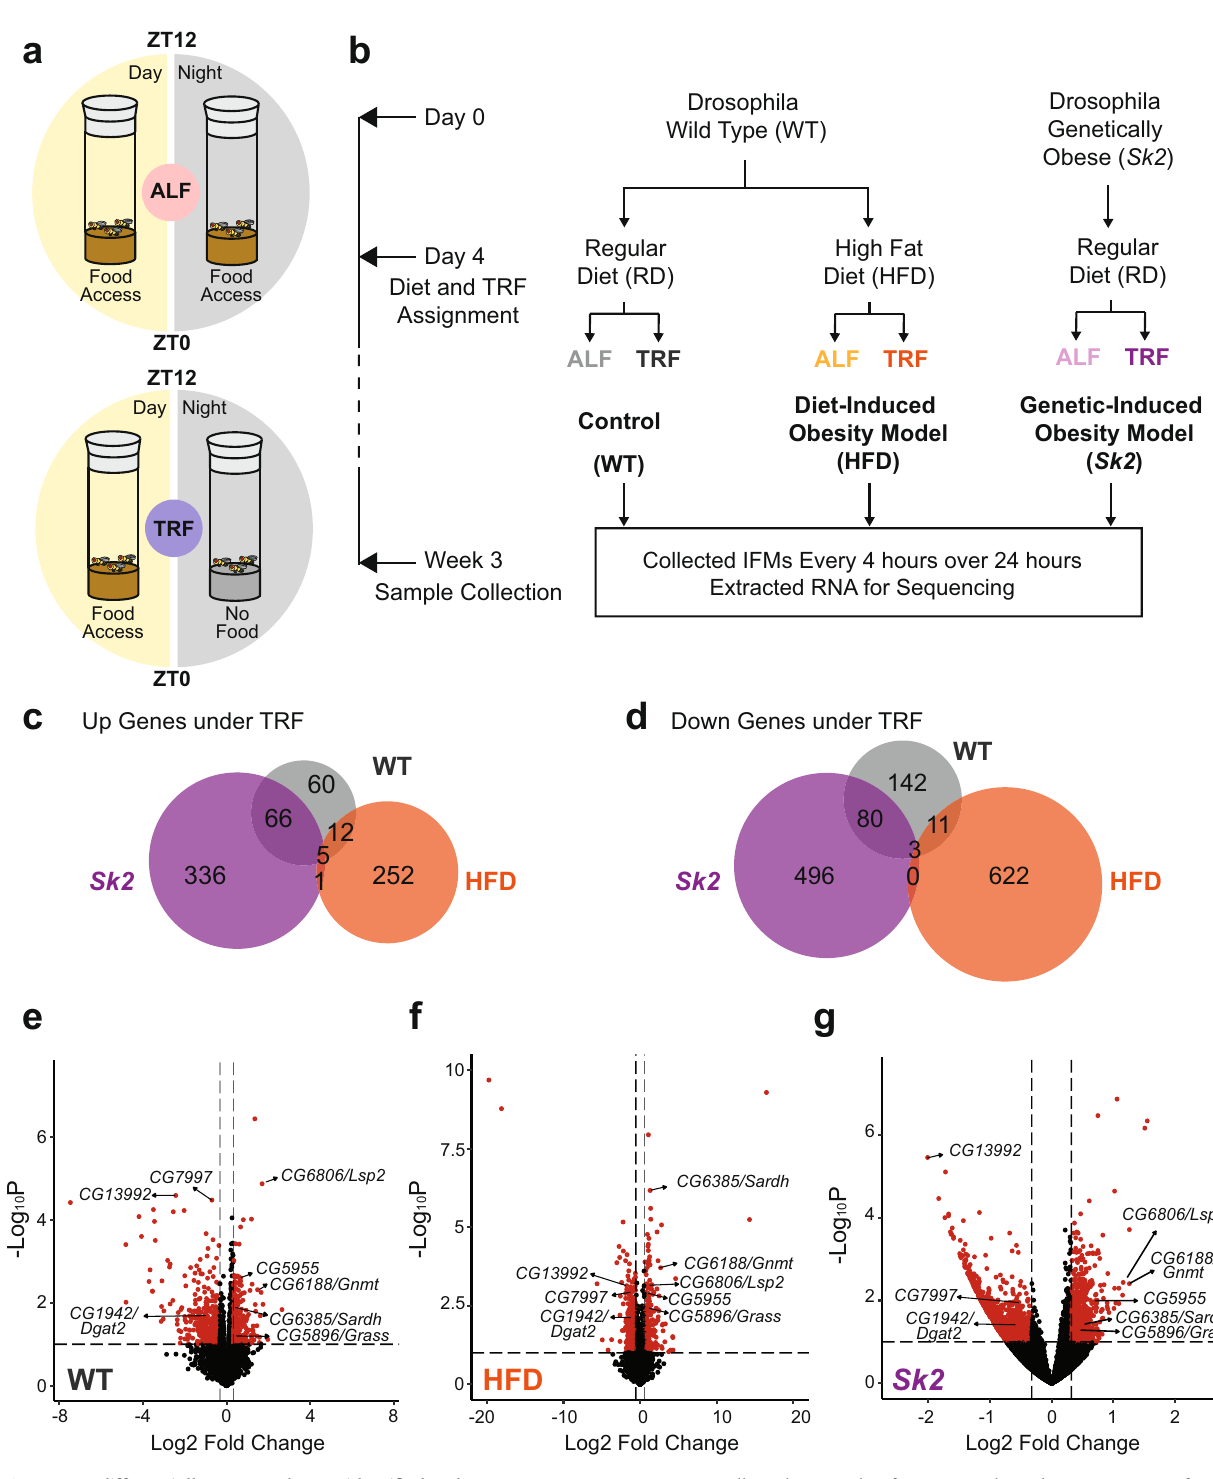
Fig.1|Commondifferentiallyexpressedgenesidenti fi edunderTRFversusALF in WT, HFD, and Sk2 fl ies. a Schematic depicting the timing of food access in ALF ( ad libitum feeding) and TRF (time-restricted feeding). In ALF, fl ies have unrest- rictedaccesstofoodduringtheday(yellow)andnight(gray).InTRF, fl iesconsume food only during the 12h of daytime. b Flow chart depicting the experimental setup. Wild-type and genetically obese mutant Sk2 fl ies were separated into respective food types either a regular diet (RD) or high-fat diet (HFD) to establish WT, HFD, and Sk2 conditions. Flies were further separated into either ALF or TRF.